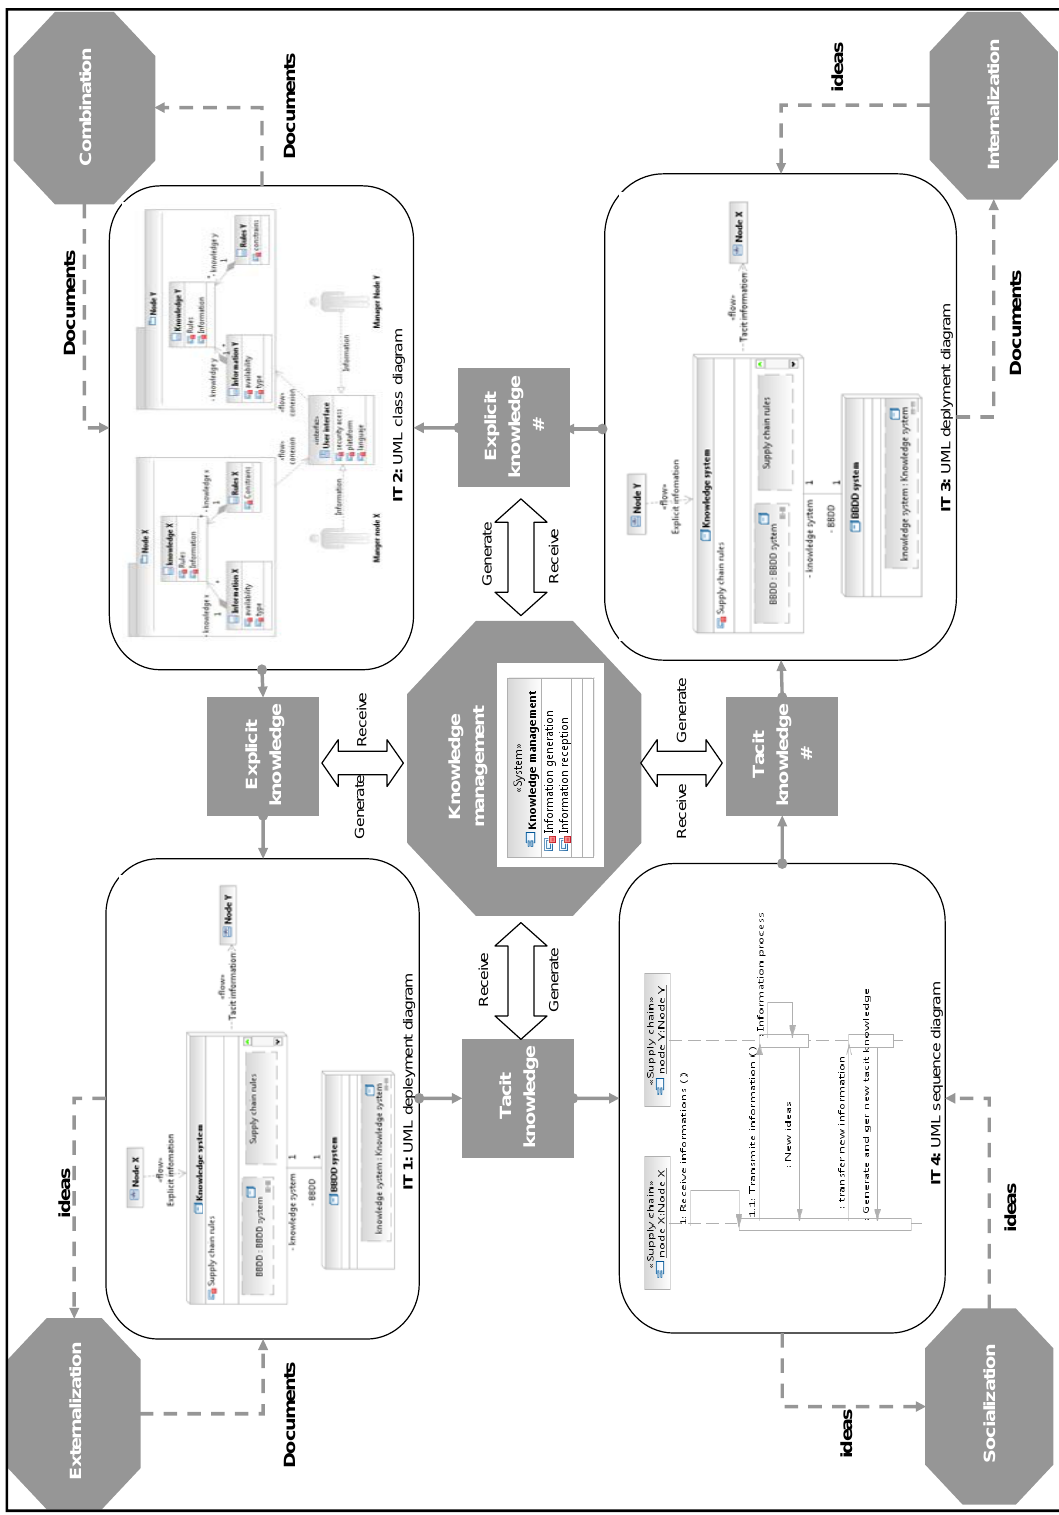
Figure 3. “Collaborative knowledge management UML-based framework. A conceptual